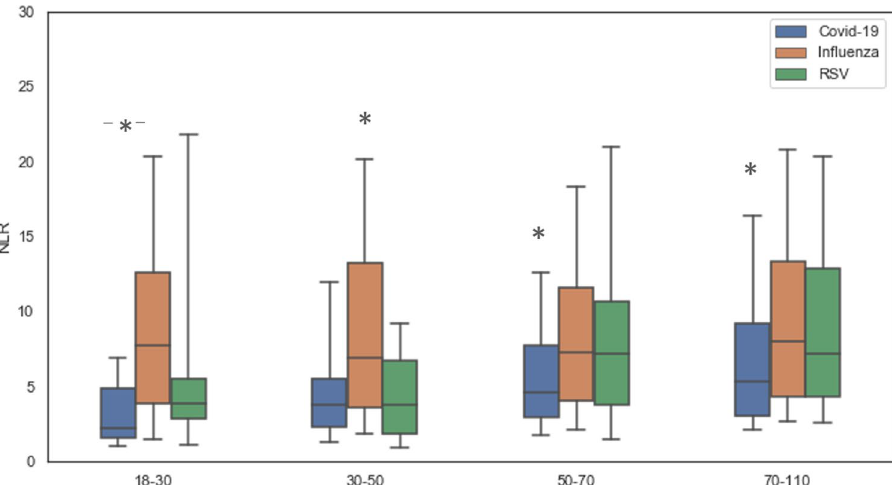
Figure 1. NLR levels stratified by age groups. For each age group level of NLR was compared among COVID-19, Influenza and RSV patients. The average levels are displayed by mean and SD. NLR neutrophil-to-